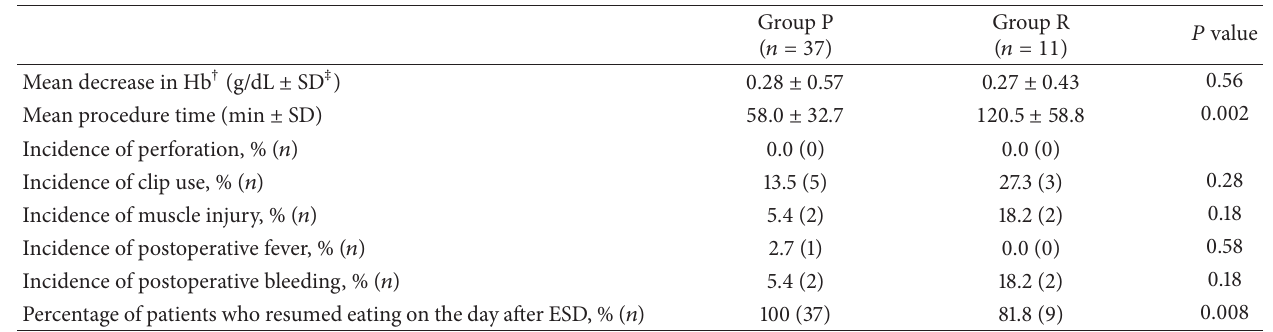
Table 4: Results for lesions in region